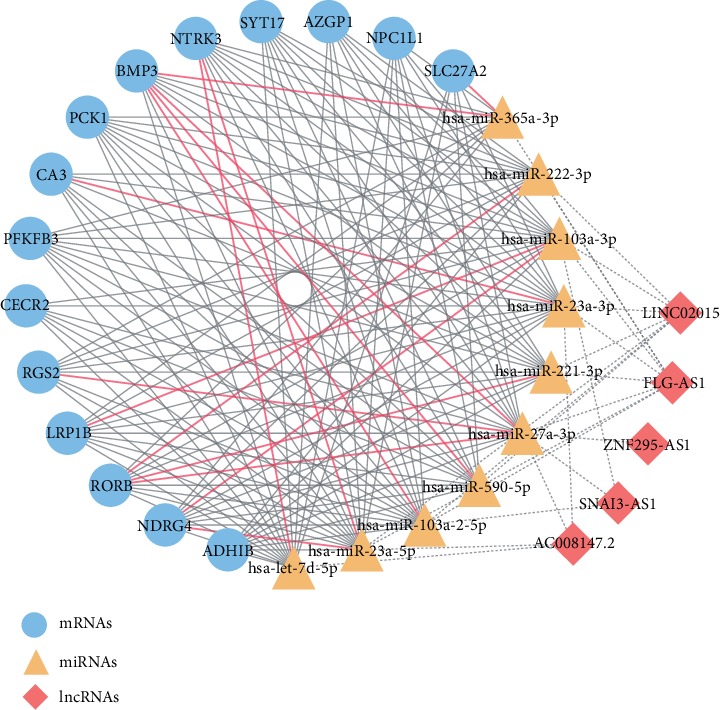
lncRNA-miRNA-mRNA network. This network consisting of five lncRNAs, ten miRNAs, and 15 mRNAs. The lncRNA-miRNA interactions are indicated by dashed lines. The mRNA-miRNA interactions are indicated by solid lines. The solid red line indicates that these interactions are confirmed by at least seven algorithms. The symbols used in the figure are indicated on the right.